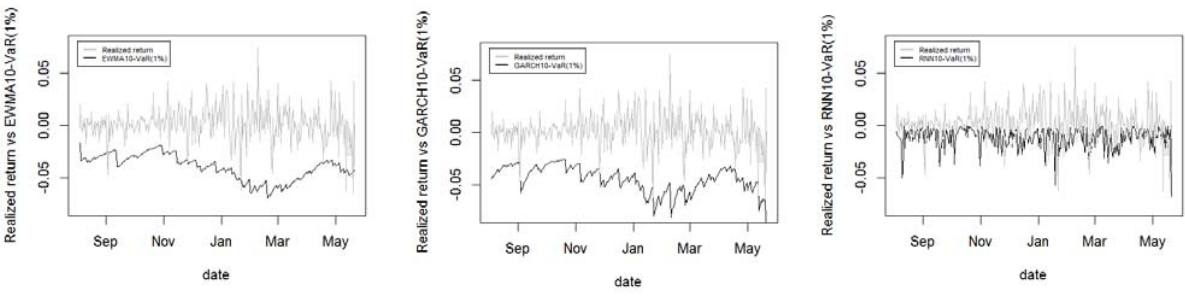
Figure A5. Out of sample realized return vs. 5 days ahead VaR (1%) of EWMA, GARCH and RNN model.